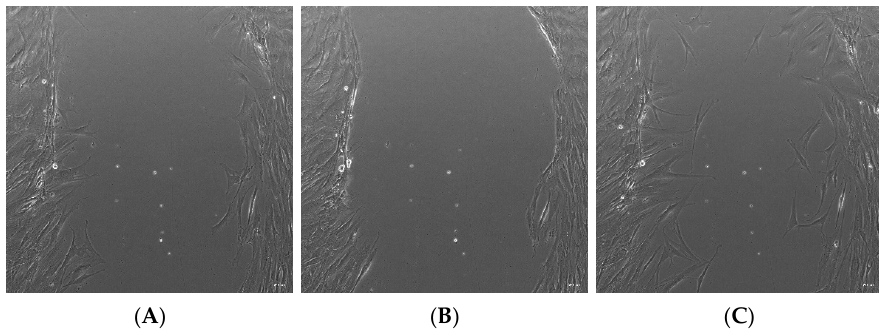
Figure 3. Representative bright-field images of the in vitro wound healing assay. ( A ) The “wound” was created by a line scratch across the hBM-dMSCs monolayer. Images were analyzed after ( B ) 12 and ( C ) 24 h of treatment. The images were taken in 10× magnification, and the scale bar represents 200 µm.